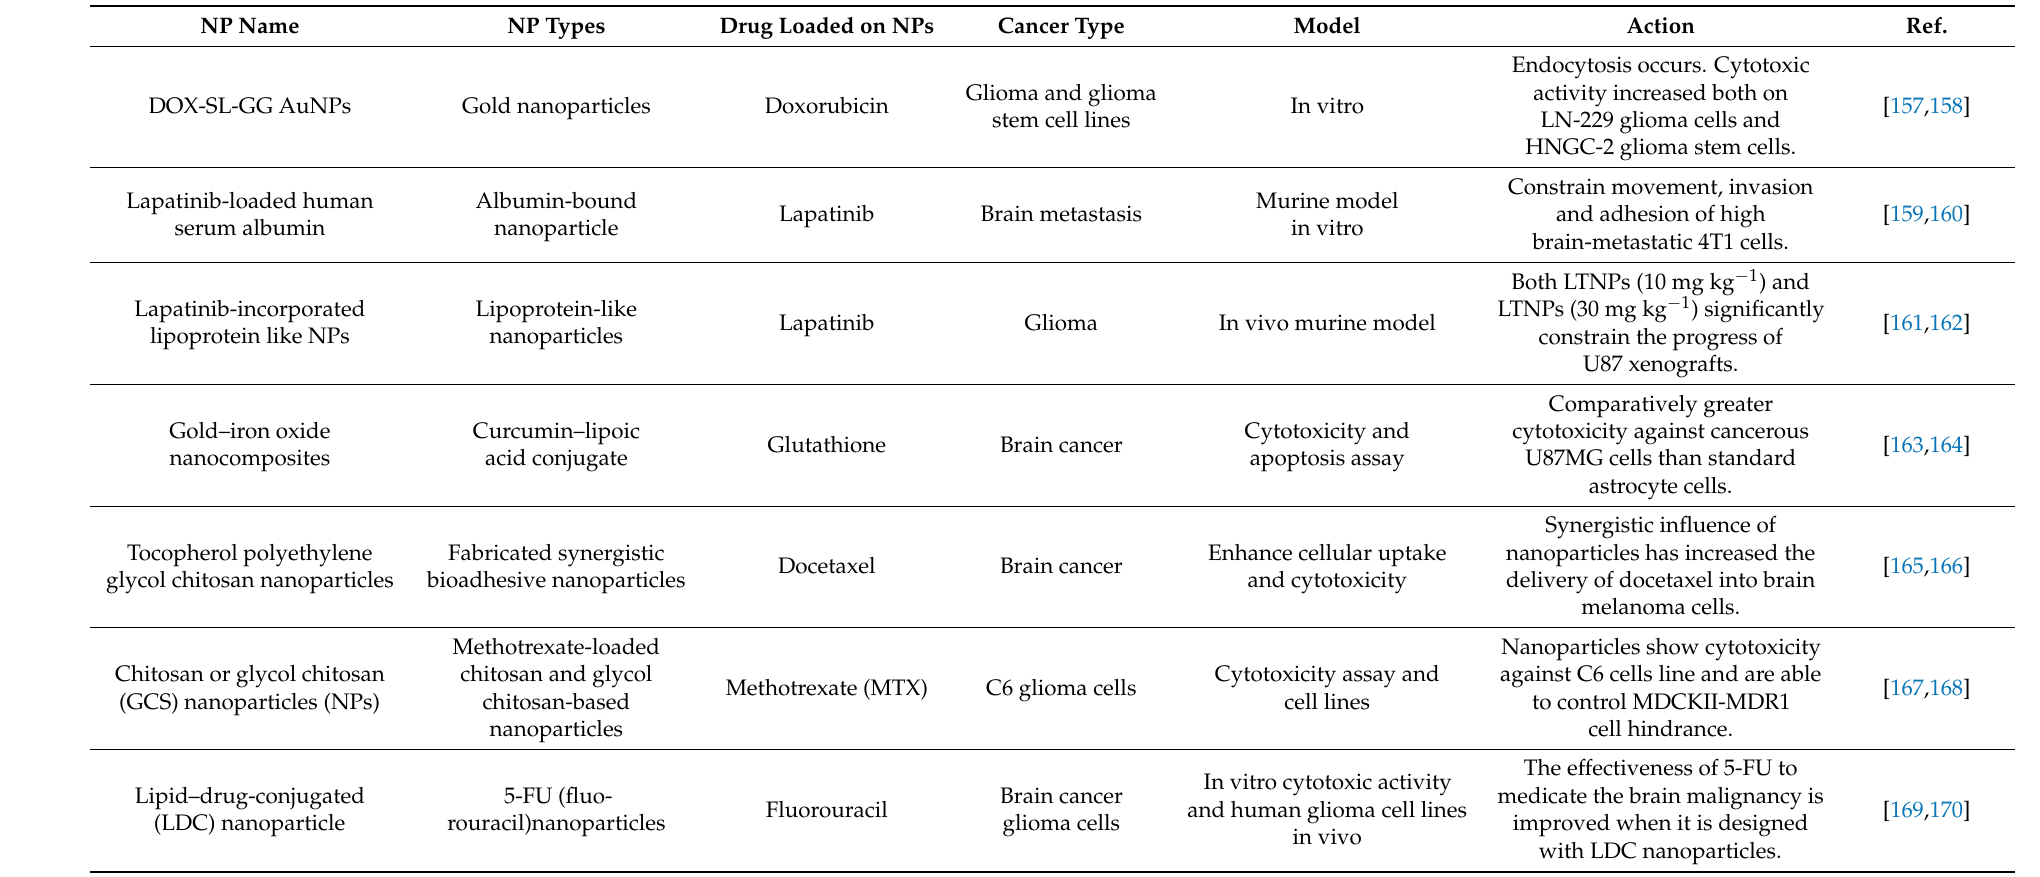
Table 3. Various nanoparticles involved in brain cancer treatment in recent